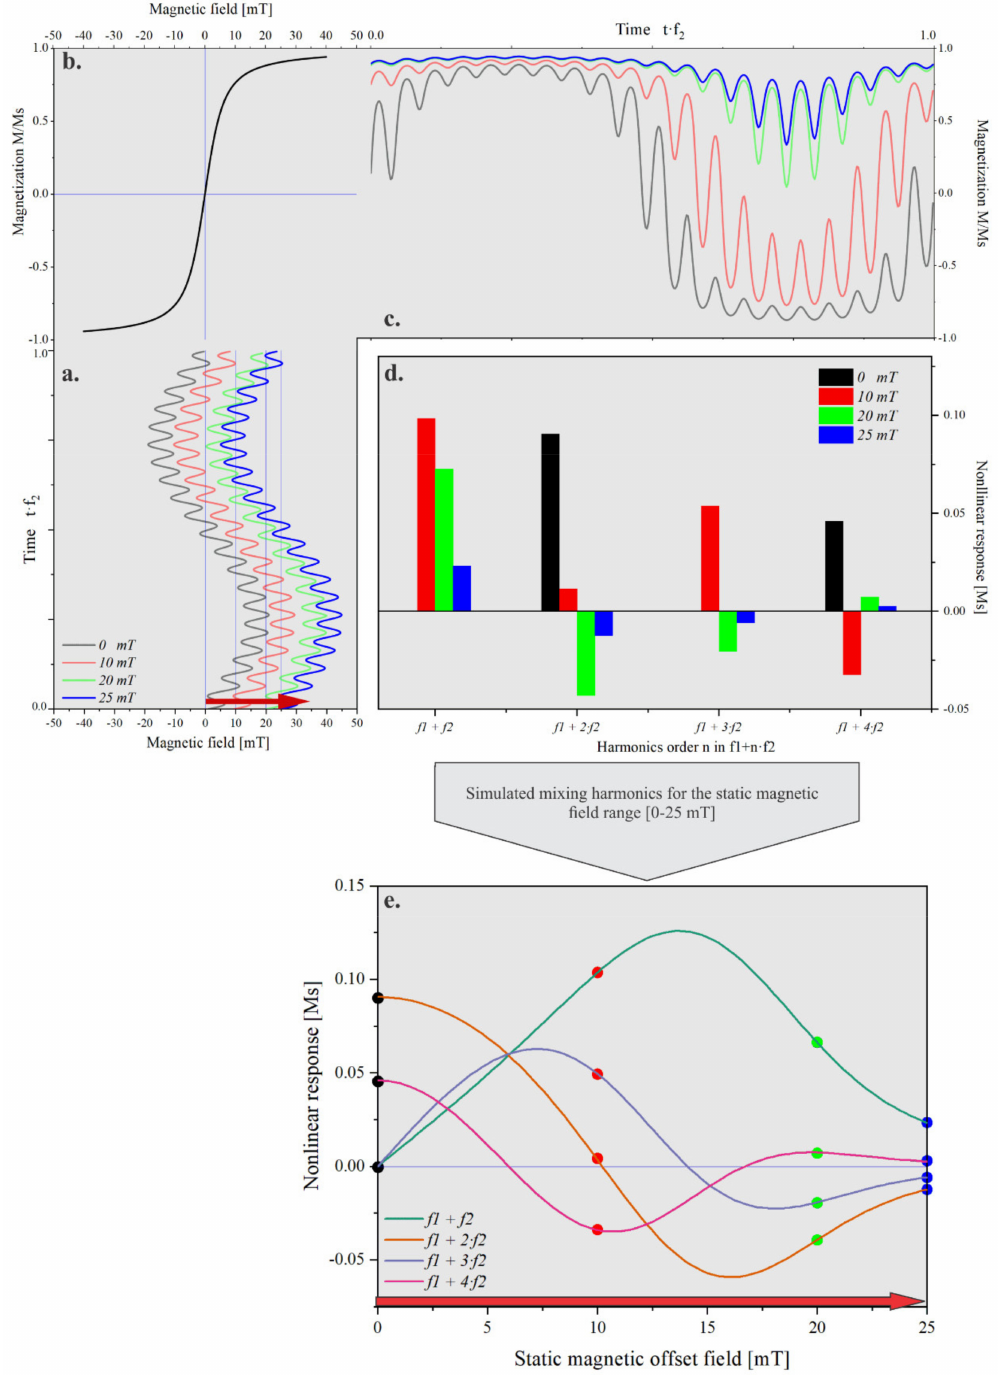
Figure 1. Two frequency magnetic excitation fields ( f 1 , high frequency and f 2 , low frequency) ( a ) were applied to the ensemble of superparamagnetic magnetic nanoparticle with a magnetic moment of 200 k µ B ( b ). The response of the particles was obtained from their nonlinear magnetization containing even and odd frequency mixing harmonics ( c ). In the absence of a static magnetic offset field, only odd harmonics appeared. Even harmonics emerged upon introducing a static magnetic offset field B 0 ( d ). The nonlinear response traces showed specific features upon variation of the static magnetic offset field, such as maxima, minima, and zero crossings ( e